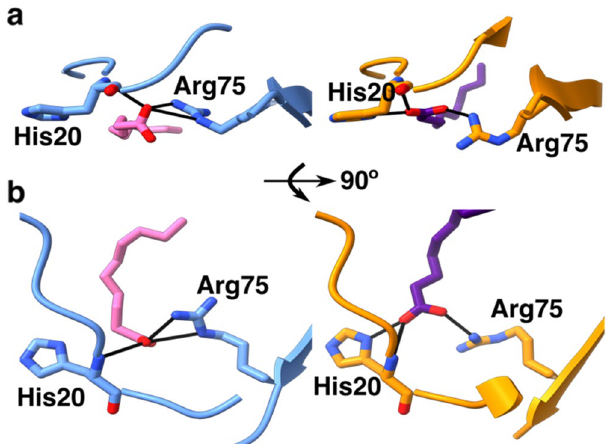
Figure 6. Detail showing the interactions between His20 and Arg75 to decanoic acid. ( a ) “front” view showing how the Arg75 in the SeMet-Rns, in blue, is above the decanoic acid (left panel) while in the native-Rns, in orange, Arg75 (right panel) is alongside the fatty acid. ( b ) “Top” view with the SeMet-Rns in blue (left panel) and native-Rns in orange (right panel). Images created with ChimeraX 38